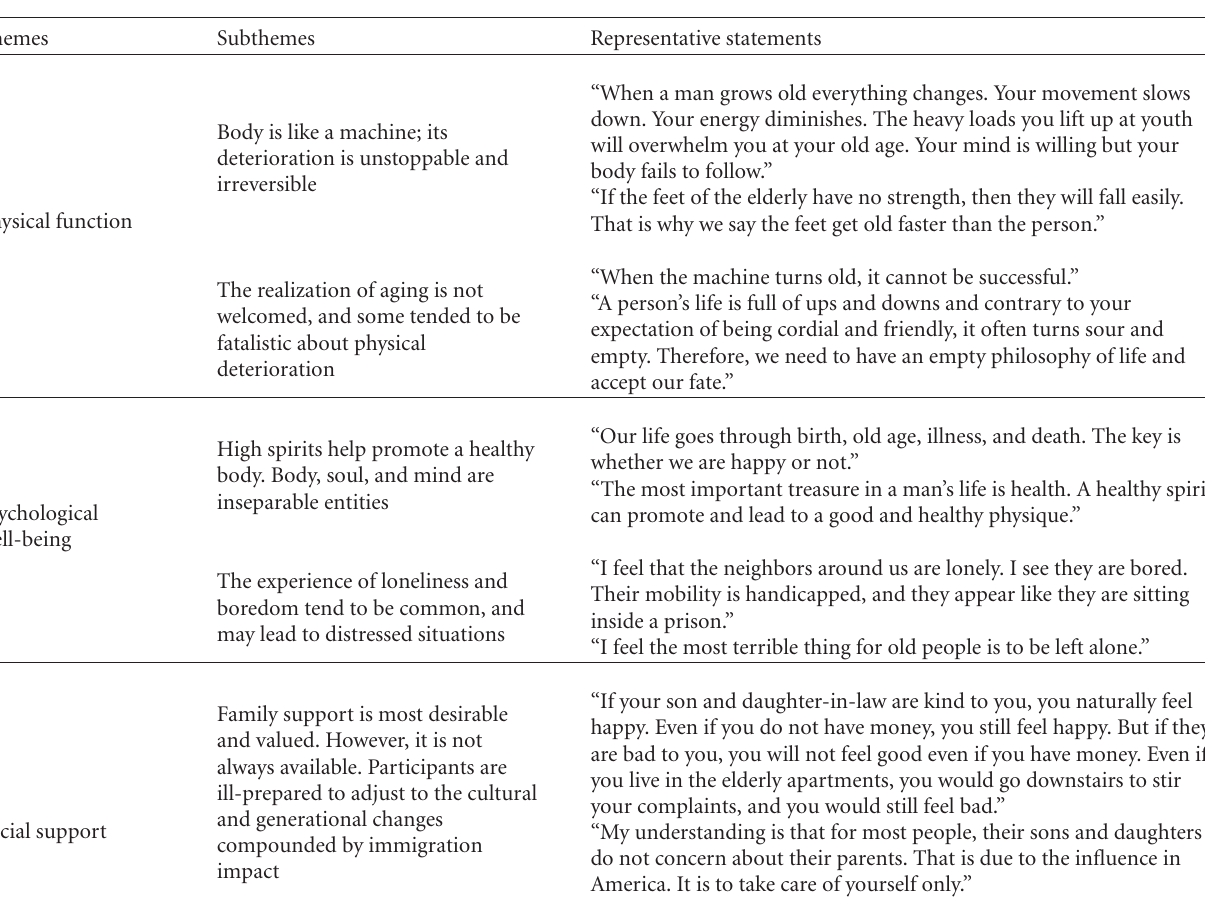
Table 1: Community’s cultural views of